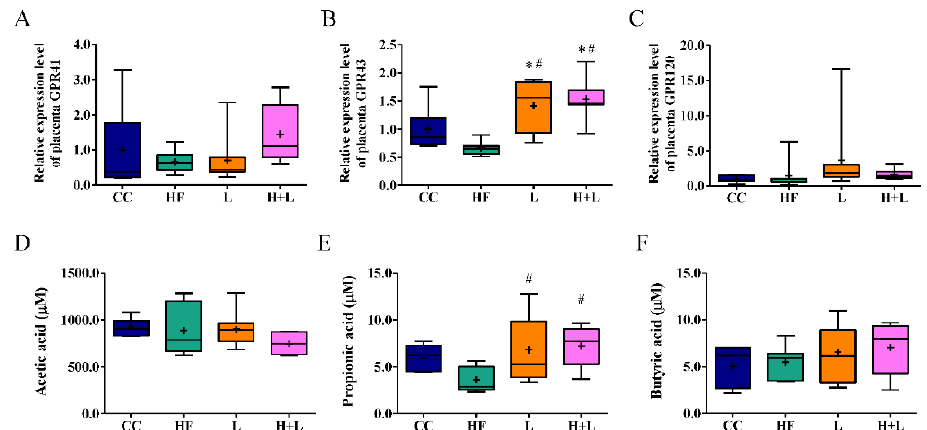
Figure 9. The effects of Lactobacillus reuteri treatment on the short-chain fatty acid cascade. mRNA expression of ( A ) GPR41 ( B ) GPR43 ( C ) GPR120 in placental tissue. The housekeeping gene was 18S rRNA. mRNA expression is presented in terms of relative fold. Plasma ( D ) acetic acid, ( E ) propionic acid, and ( F ) butyric acid levels of dams as determined by gas chromatography. * Compared to the CC group, p < 0.05; # compared to the HF group, p < 0.05. CC, maternal control diet group; HF, maternal high-fat diet group; L, maternal control diet with prenatal L. reuteri treatment; H + L, maternal high-fat diet with prenatal L. reuteri treatment; GPR, G-protein-coupled receptor. The diagram shows the mean level (cross symbol) “+”.